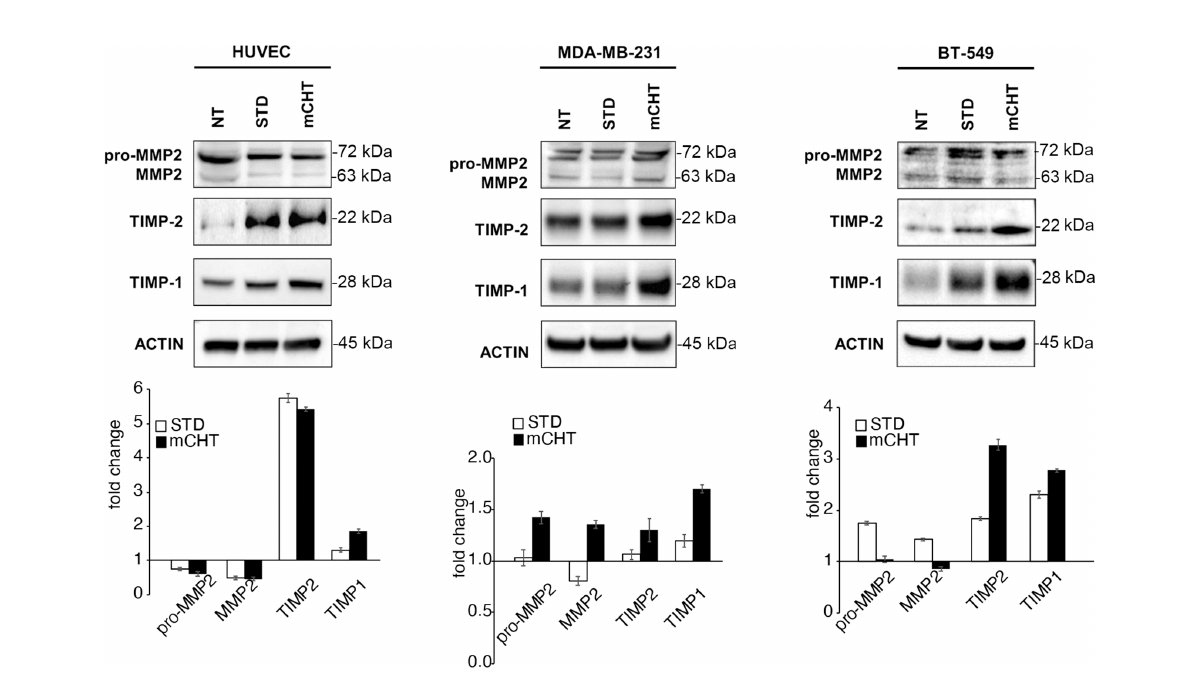
FIGURE 6 mCHT and STD administration of 5-FU+VNR differently modulate MMPs inhibitors in HUVECs and TNBC cells. On the top: representative western blots of HUVECs, MDA-MB-231 and BT-549 cells treated with mCHT or STD 5-FU+VNR. A representative experiment out of three is shown. On the bottom: protein expression levels as calculated by densitometry of the western blot results. Quanti fi cation of protein expression levels was normalized to the loading control actin and compared to the untreated control set as 1. Values represents the average ± SD of three independent